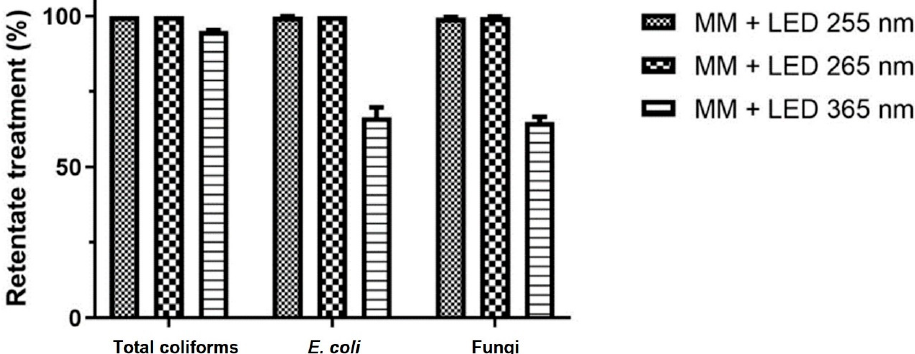
Figure 3. Inactivation percentage of the retentate in terms of total coliforms, E. coli and fungi after dead-end filtration of the modified membrane with LEDs that emits at 255, 265 and 365 nm.